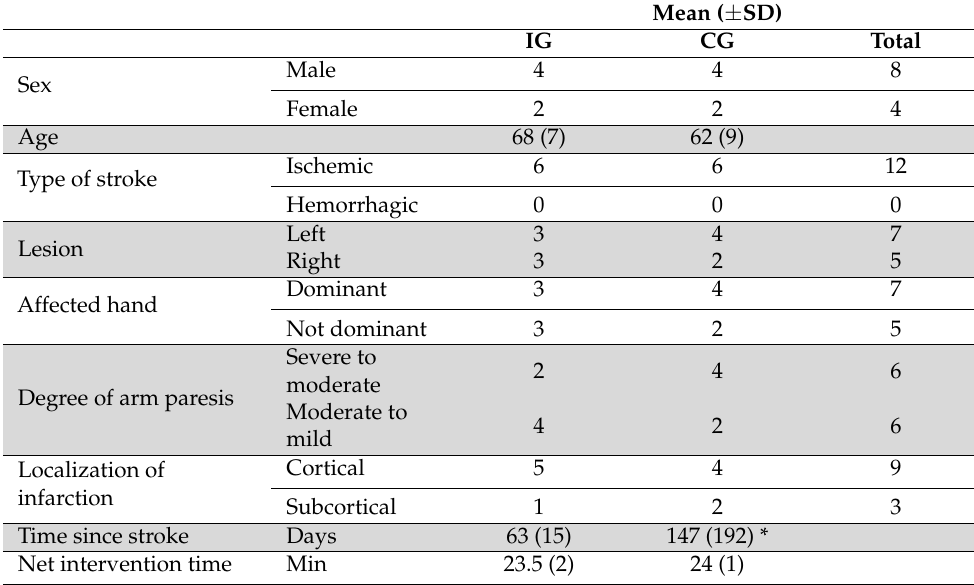
Table 1. Demographic data and characteristics of the intervention and control